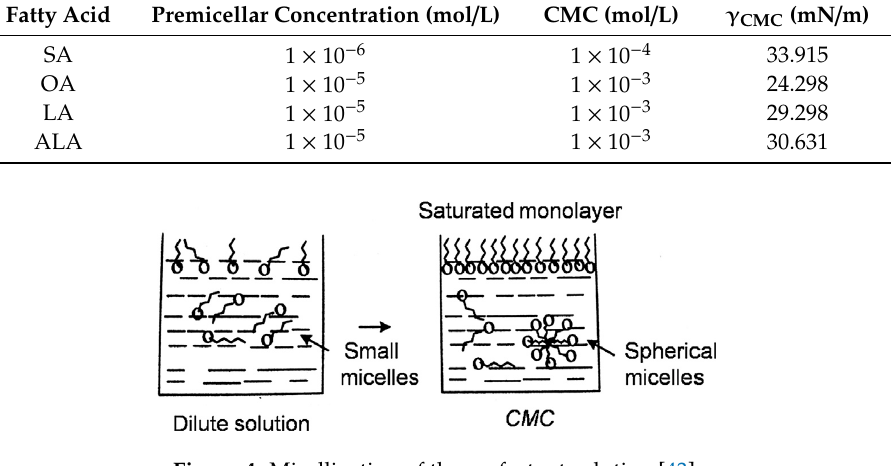
Figure 3. Surface tension variation as a function of the fatty acid concentration. Table 2. The premicellar concentration, CMC and γ CMC of studied fatty acid at 25 °C.